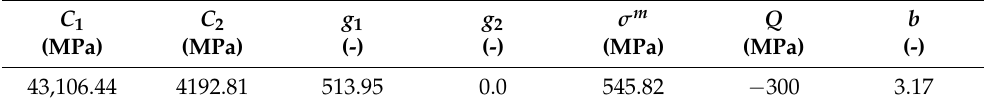
Figure 6. ( left ) Stress–Strain hysteresis loop and ( right ) reduction of the maximum stress in uniaxial fatigue tests with a strain amplitude of E 33 = 0.55% and an amplitude ratio of R = − 1. Table 4. Calibrated J2 model